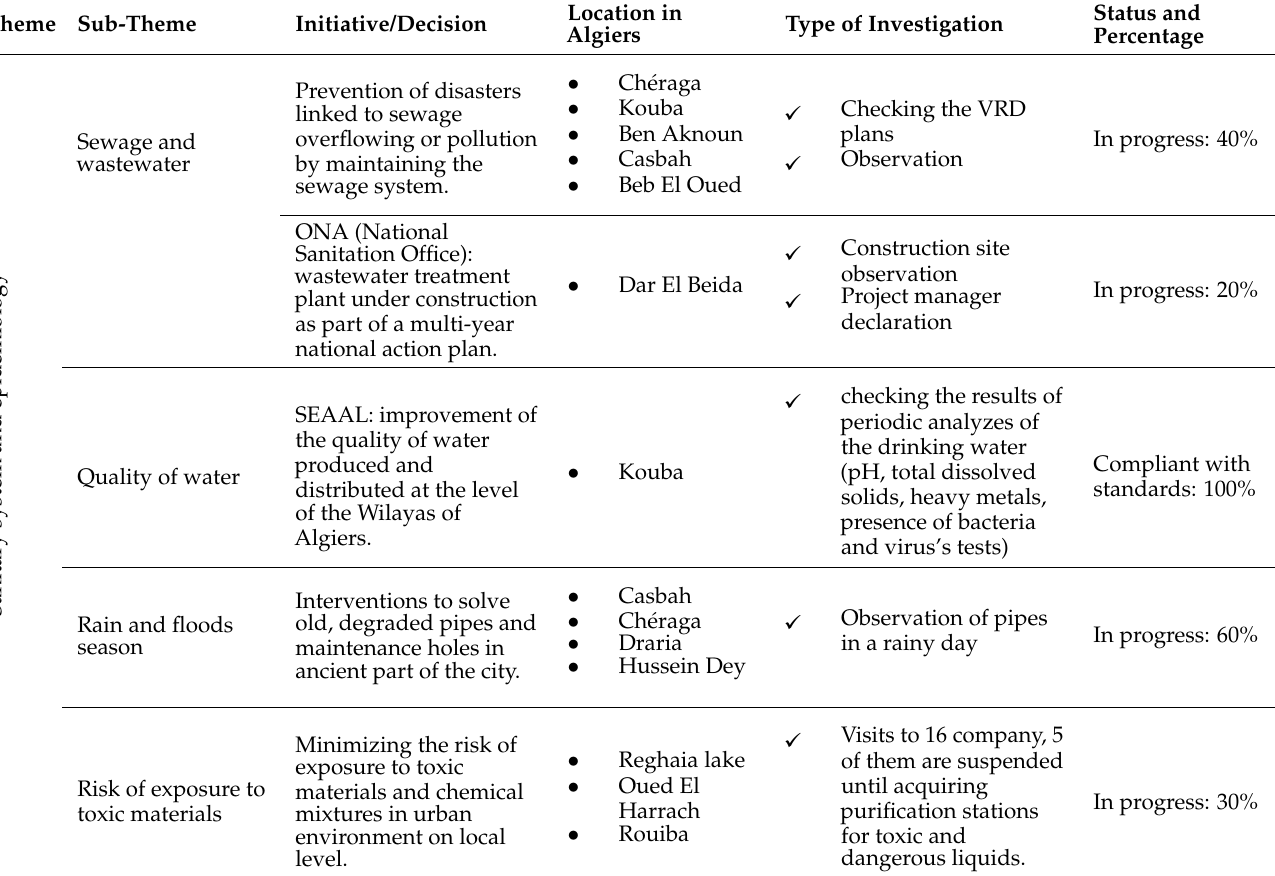
Table 4. On-site investigation steps.